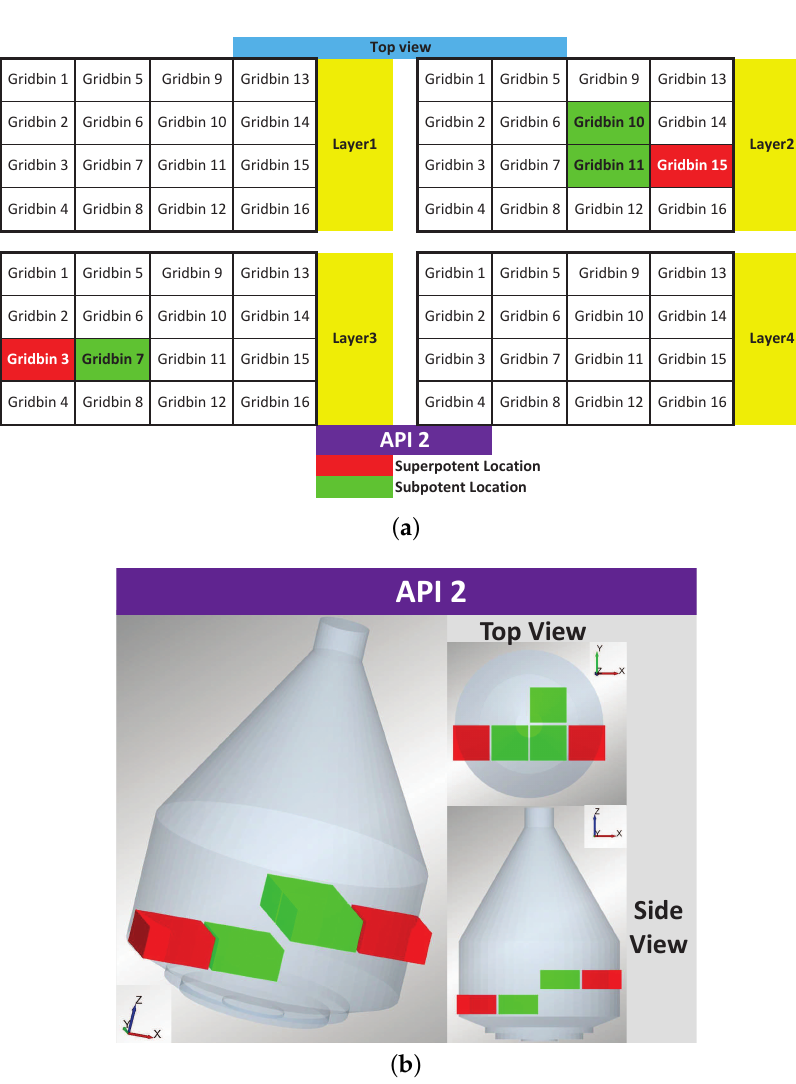
Figure 7. Super-potent and sub-potent regions in the mixing of API 2 represented as: ( a ) the Cartesian system; ( b ) 3D